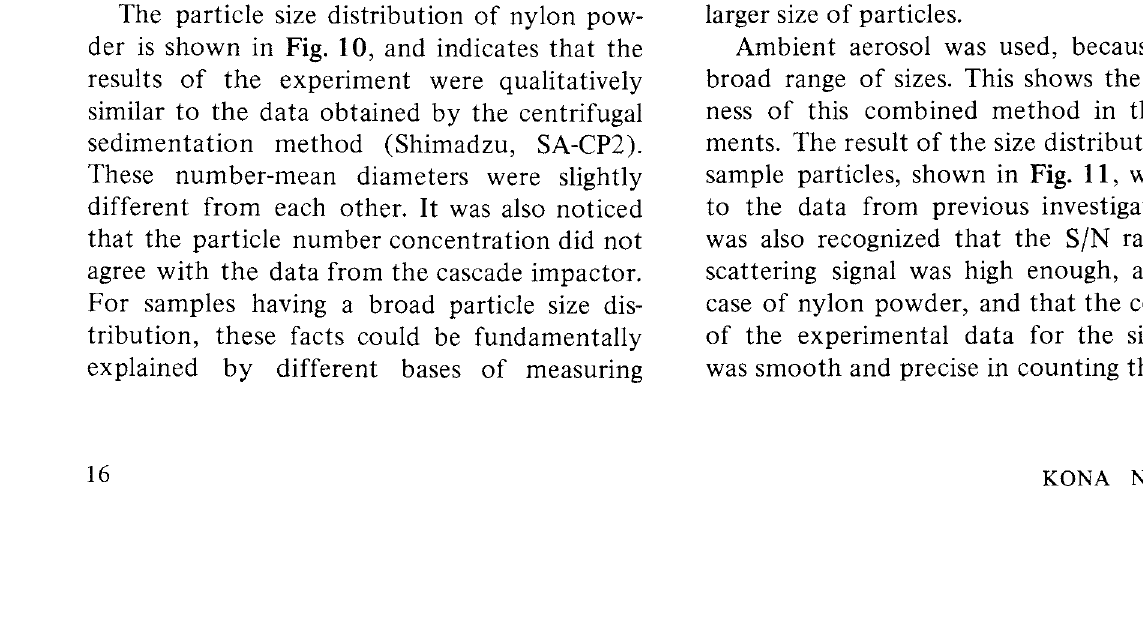
principles and by an error which occurred due to the conversion of the volume-mean diameter to a number-mean one. However, the S/N ratio of the scattering signal was extremely high for all experimental conditions despite differences between the volumetric and counting